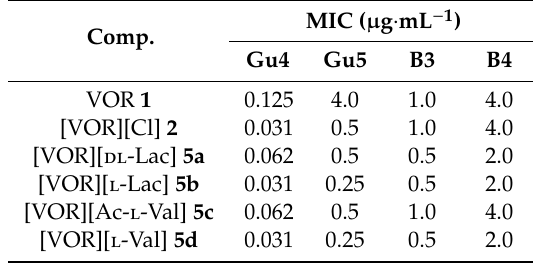
Table 3. Comparison of antifungal in vitro activity of VOR and its salts against drug-susceptible (Gu4 and B3) and multidrug-resistant (Gu5 and B4) Candida albicans clinical strains. MICs were determined by the microtiter serial twofold dilution method in RPMI-1640 medium. MIC ( μ g·mL − 1 ) Comp.